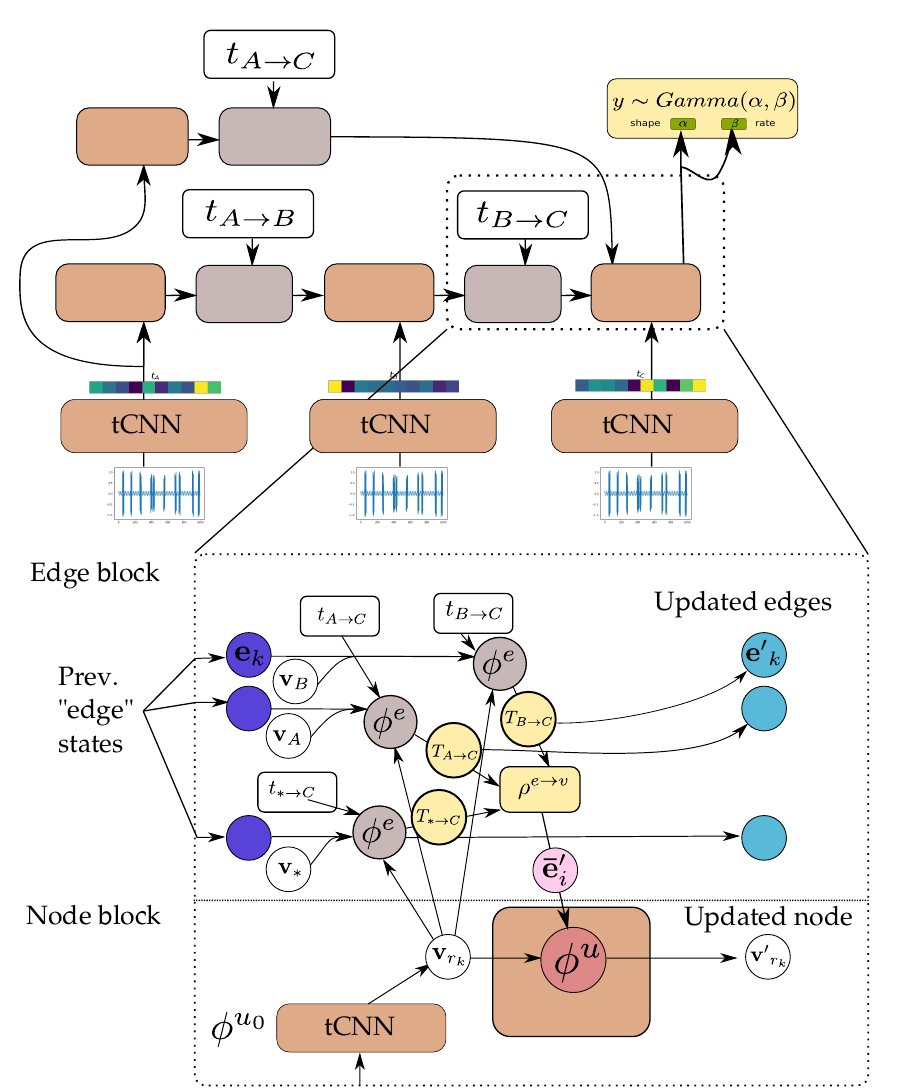
Figure 6. Detail of the GNN-tCNN . Nodes v A , v B , v ∗ correspond to sender nodes for the respec- tive edges. The updated edge states (light blue) are the same as the messages (yellow). See also Algorithm 1 and Figure